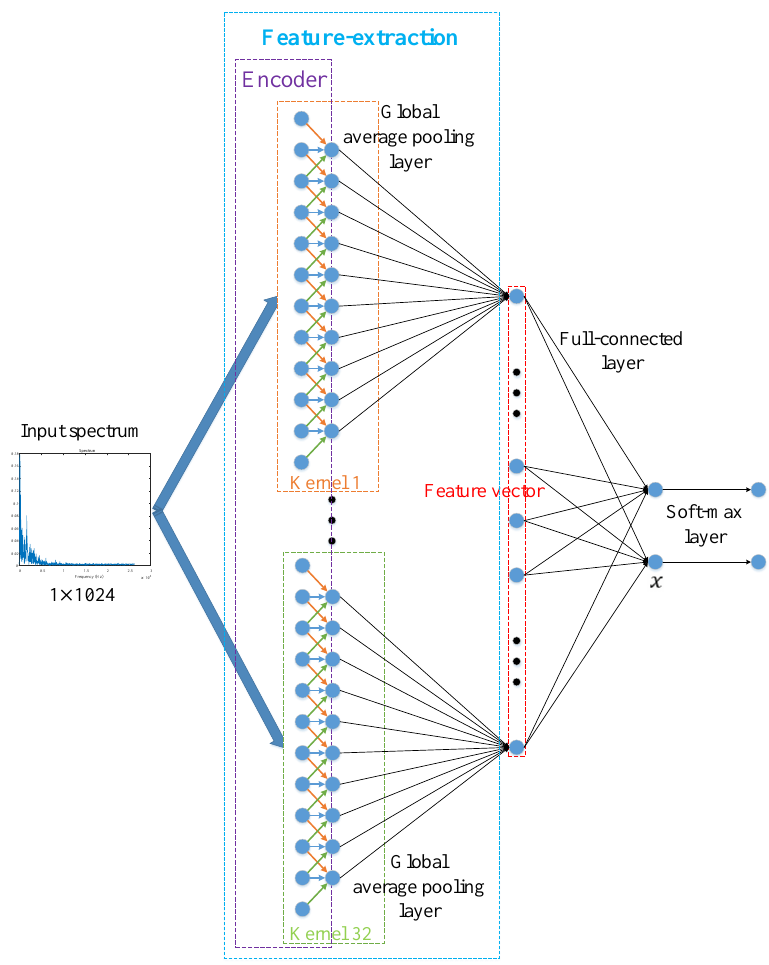
Figure 5. Procedure of the traditional supervised training algorithm for